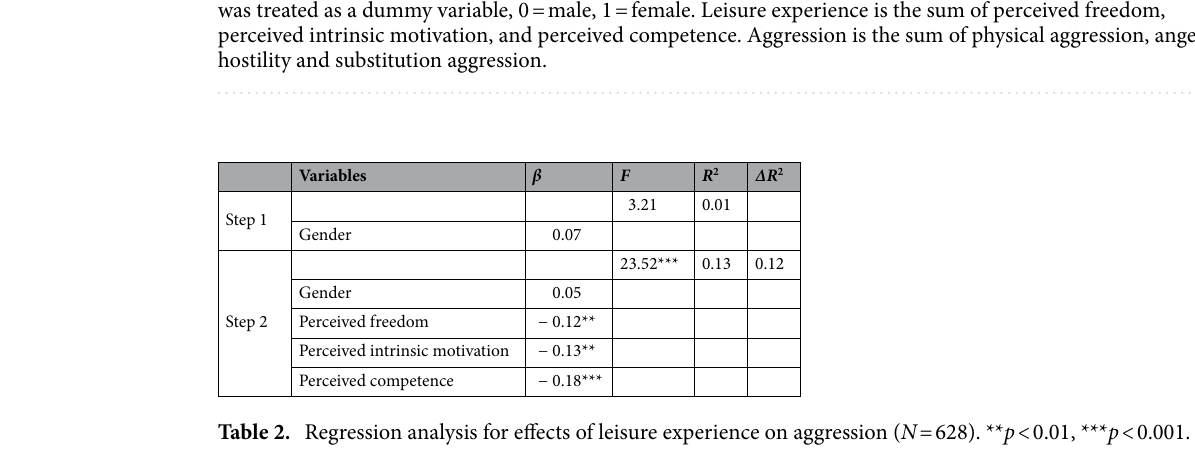
Table 2. Regression analysis for effects of leisure experience on aggression ( N = 628). ** p < 0.01, *** p < 0.001.